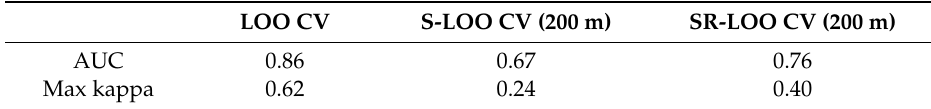
Table 5. Threshold-independent accuracy of coarse substrate model using spatial and non-spatial cross validation (CV) approaches and with spatially independent training data.